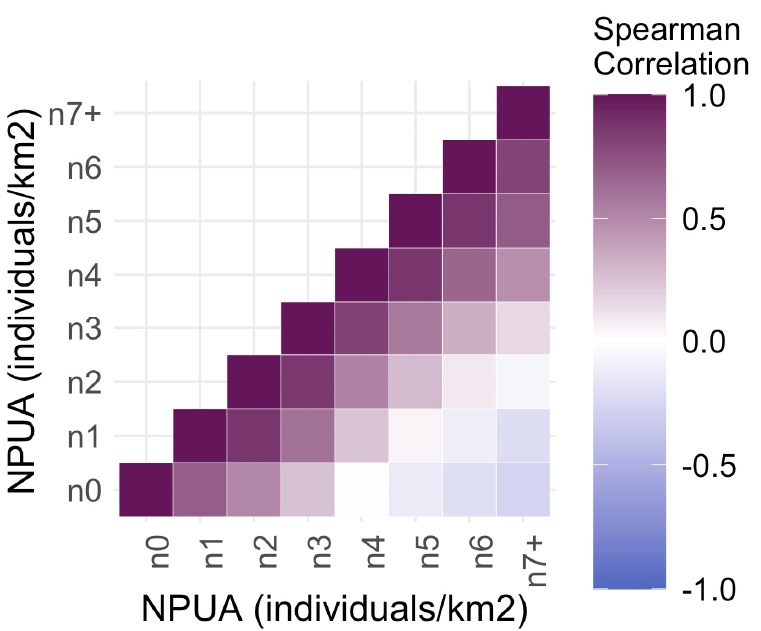
with the abundance of adults of age groups 5, 6, and 7+. On the other hand, the abundance of adult Chilean hake showed positive correlations, particularly the abundance of age groups 5 and 6, and less with the abundance of older adults (7+).